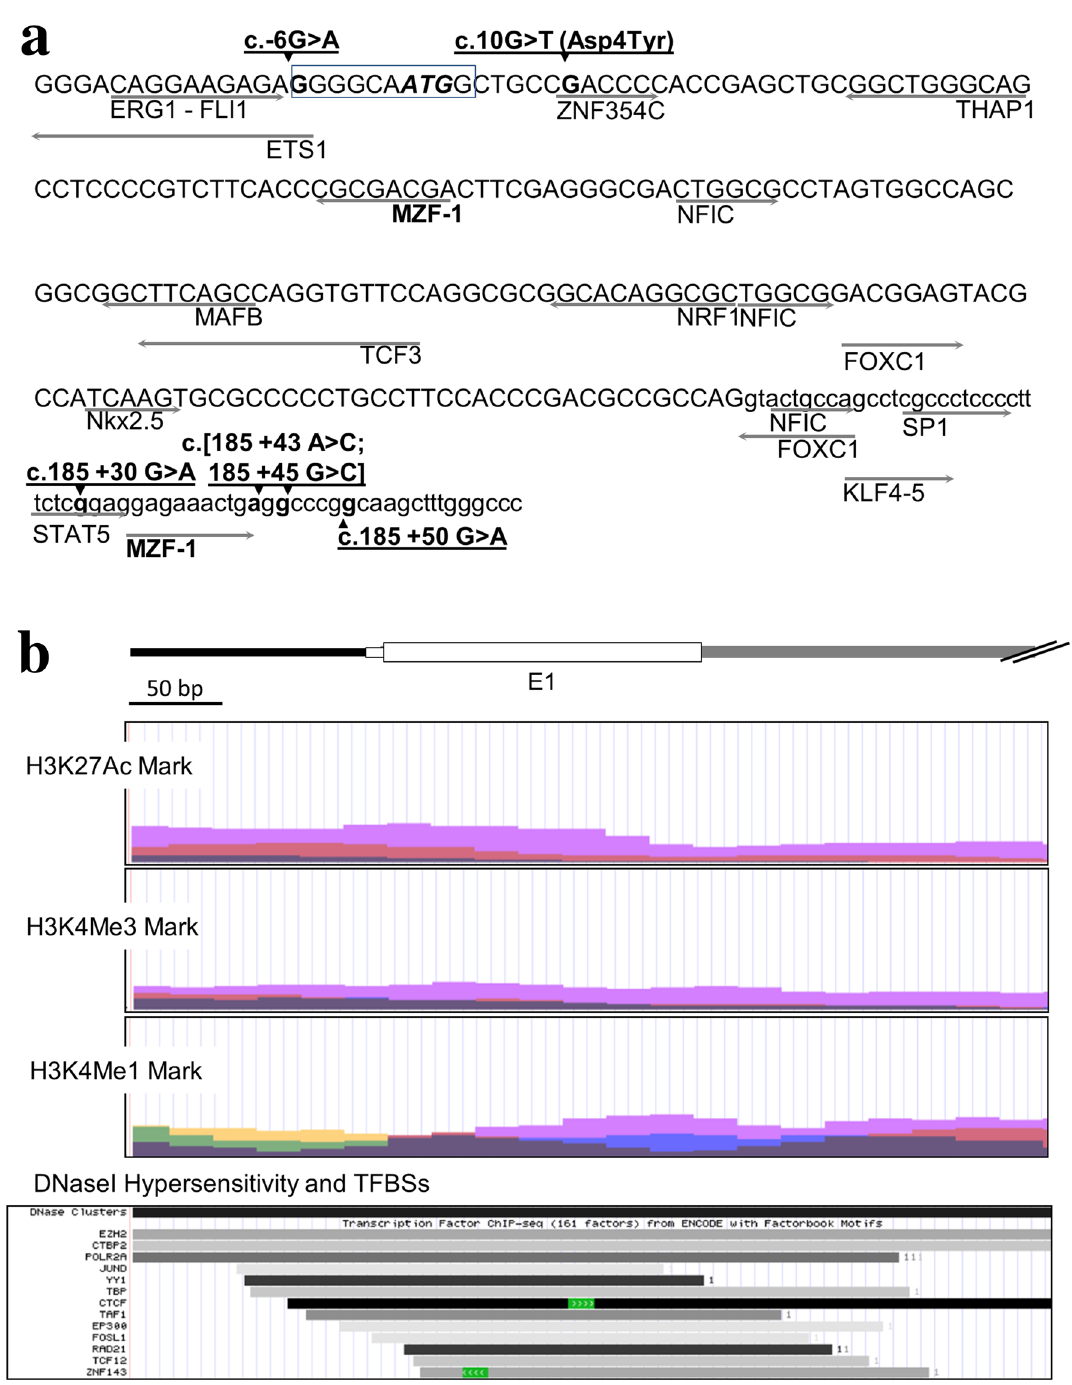
Figure 1. ANKK1 SNVs related to PD are located in the conserved 5 ′ regulatory regions of the gene. ( a ) Sequence of ANKK1 Exon 1 (capital letters) and intron 1 (lowercase) annotated with rare PD-related SNVs (bold), Kozak sequence (square), and transcription factor binding sites (TFBSs) identified by JASPAR (grey arrows). ( b ) ENCODE chromatin modifications marks of ANKK1 exon 1/intron 1 region in Human Skeletal Muscle Myoblasts (HSMM, green), Human Umbilical Vein Endothelial Cells (HUVEC, blue), Normal human epidermal keratinocytes (NHEK, violet) cell lines. Histone acetylation and methylation marks for H3K27Ac, H3K4m3 and H3K4m1 indicate promoters and enhancers. DNaseI hypersensitivity indicates regulatory regions and